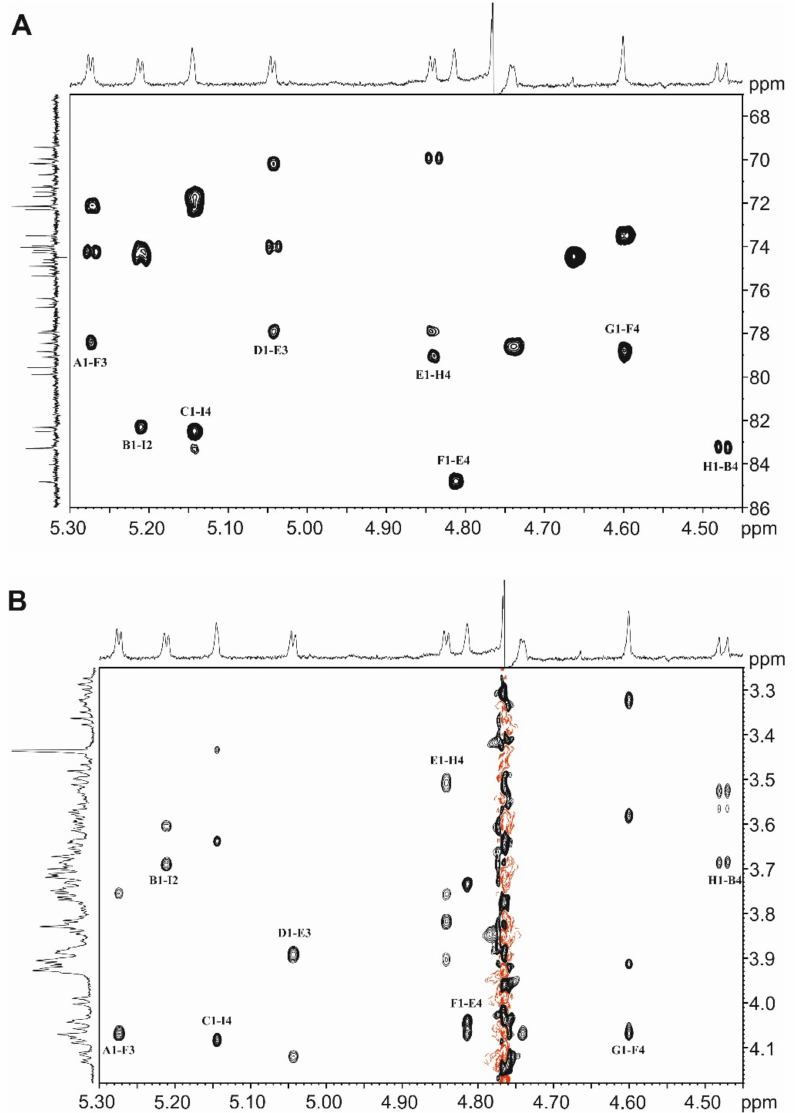
Figure 3. ( A ) Region of the 2D-HMBC spectrum and ( B ) region of the 2D-NOESY spectrum of the B. fragilis wild-type O -glycan released from glycopeptides by reductive β -elimination, showing the inter-glycosidic cross-peaks. ( A ) Long-range cross-peaks over three bonds between the anomeric protons of residues A – H to the carbon at the linkage position of the next following sugar and ( B ) NOE cross-peaks between the anomeric protons of residues A – H to the proton at the linkage position of the next following